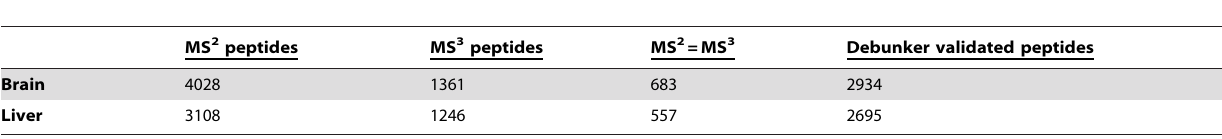
Table 1. Validation of phosphopeptides identified from MS 2 spectra with MS 3 spectra and